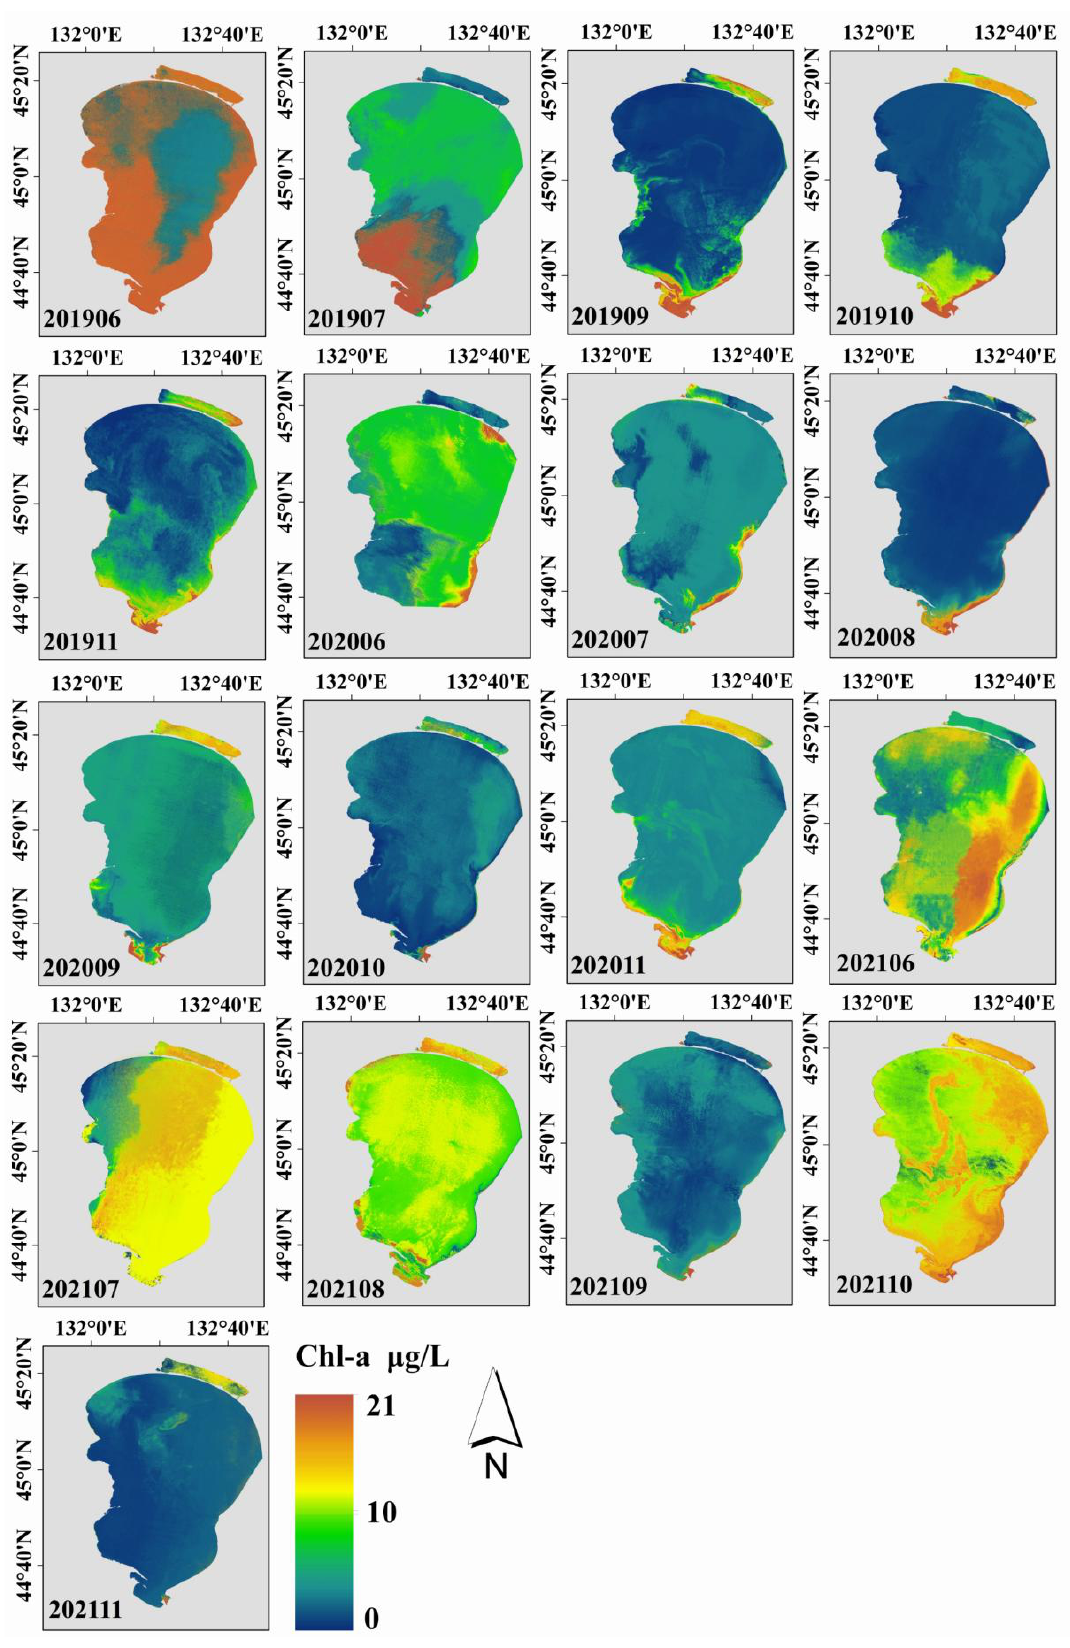
Figure 7. Spatial distribution of average Chl-a concentration in inversion results based on GF-6 WFV remote sensing images from June 2019 to November 2021.